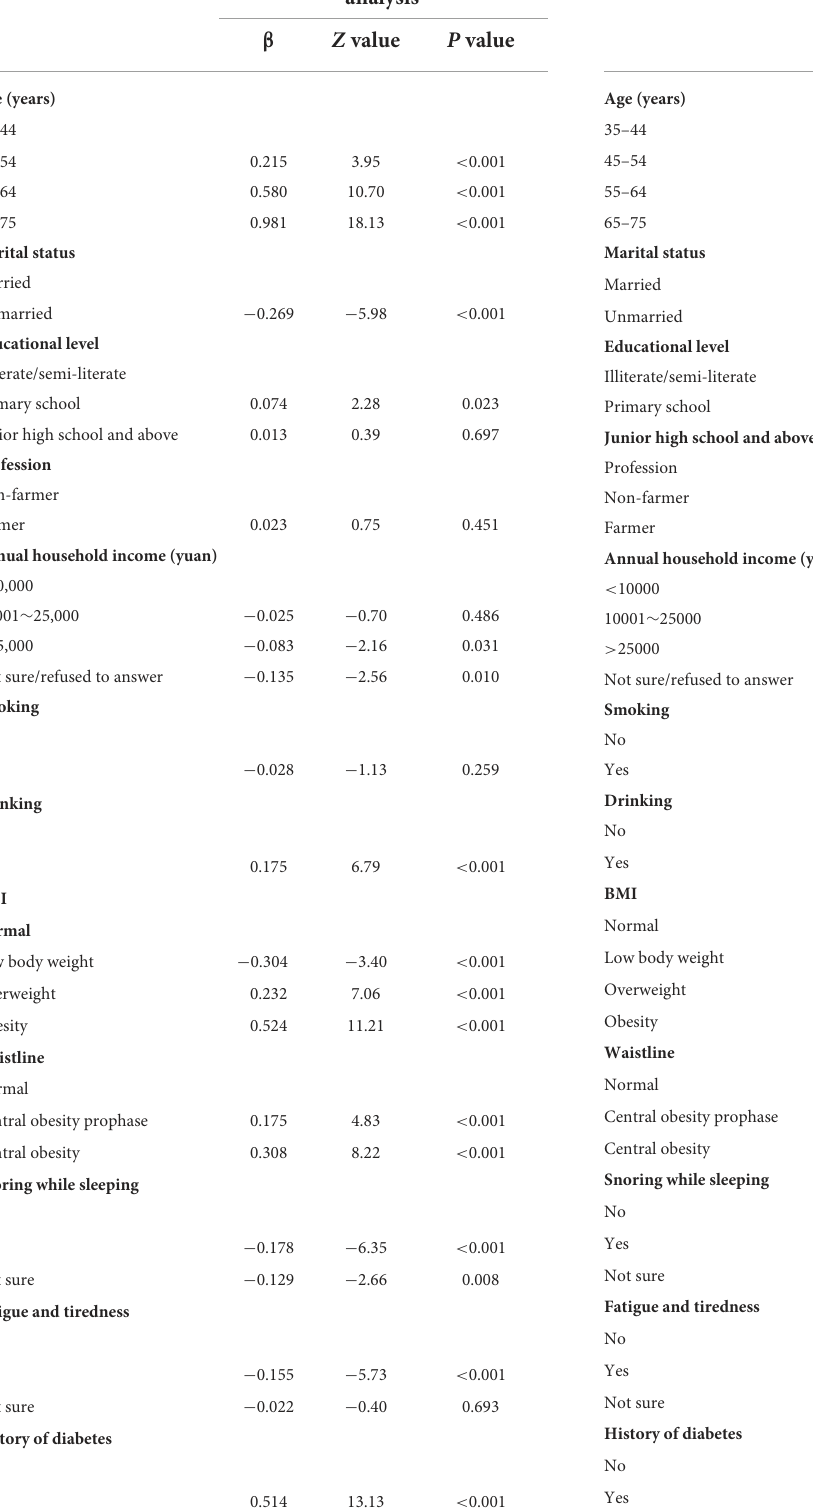
TABLE 4 Generalized Linear Mixed Model analysis of influencing factors among high-risk groups of CVD in male.